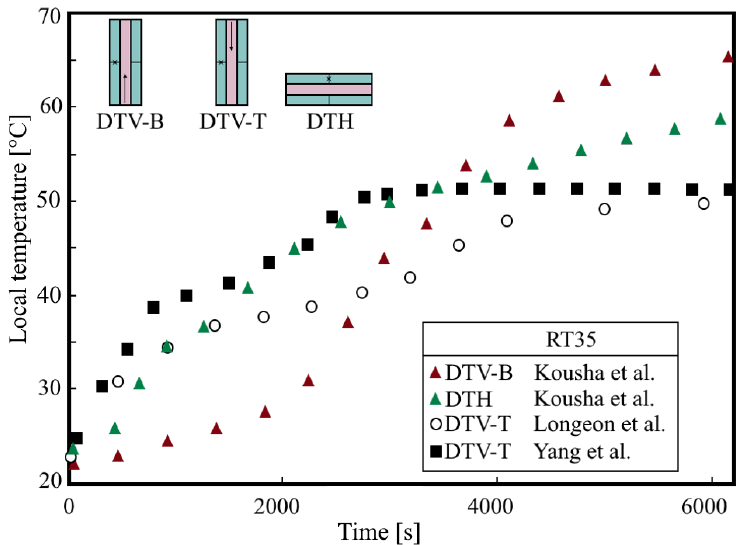
Figure 9. Influence of angle of inclination on PCM temperature location of HTF inlet [33,49,52].